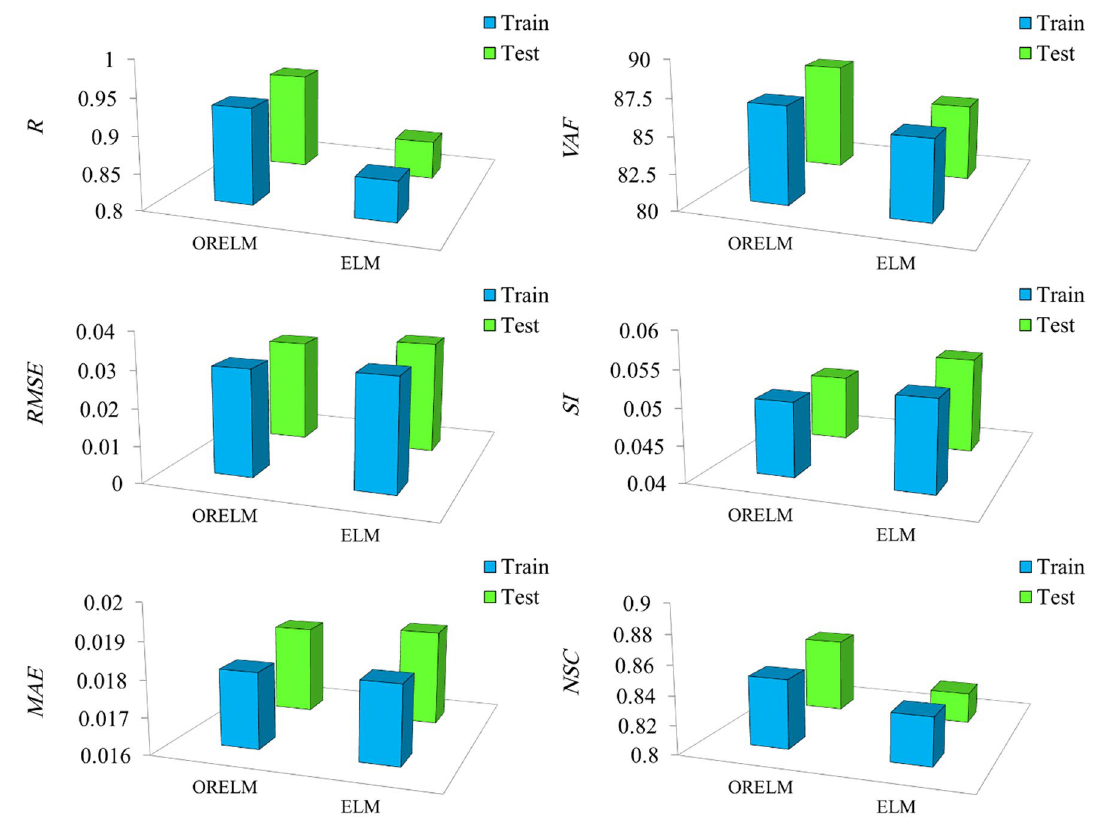
Fig. 10 Statistical indices obtained for ORELM and ELM models in both modes